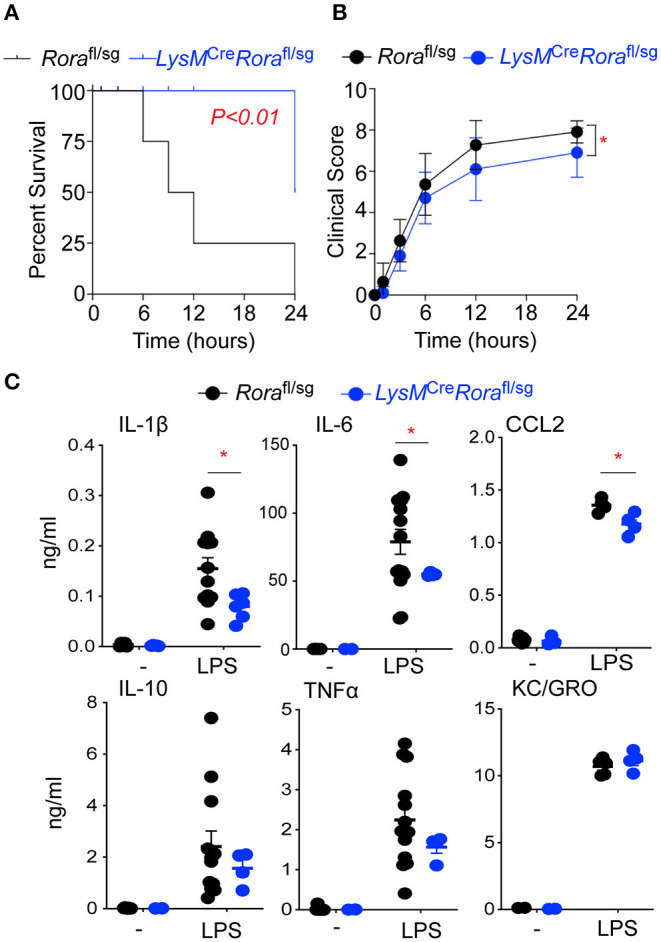
LysMCreRorafl/sg mice show decreased disease severity and an impaired ability to generate an inflammatory response in a model of endotoxic shock. Rorafl/sg (n = 11) and LysMCreRorafl/sg (n = 10) mice were challenged with 10 mg/kg ultra-pure LPS i.p. Mice were monitored periodically for 24 h post LPS injection and death (A) and clinical score (B) recorded. Blood was collected from naïve Rorafl/sg (n = 9) and LysMCreRorafl/sg (n = 5) mice (-) and Rorafl/sg (n = 12) and LysMCreRorafl/sg (n = 6) 3 h post LPS injection (LPS) and serum cytokines and chemokines determined by ELISA (C). *P < 0.05.